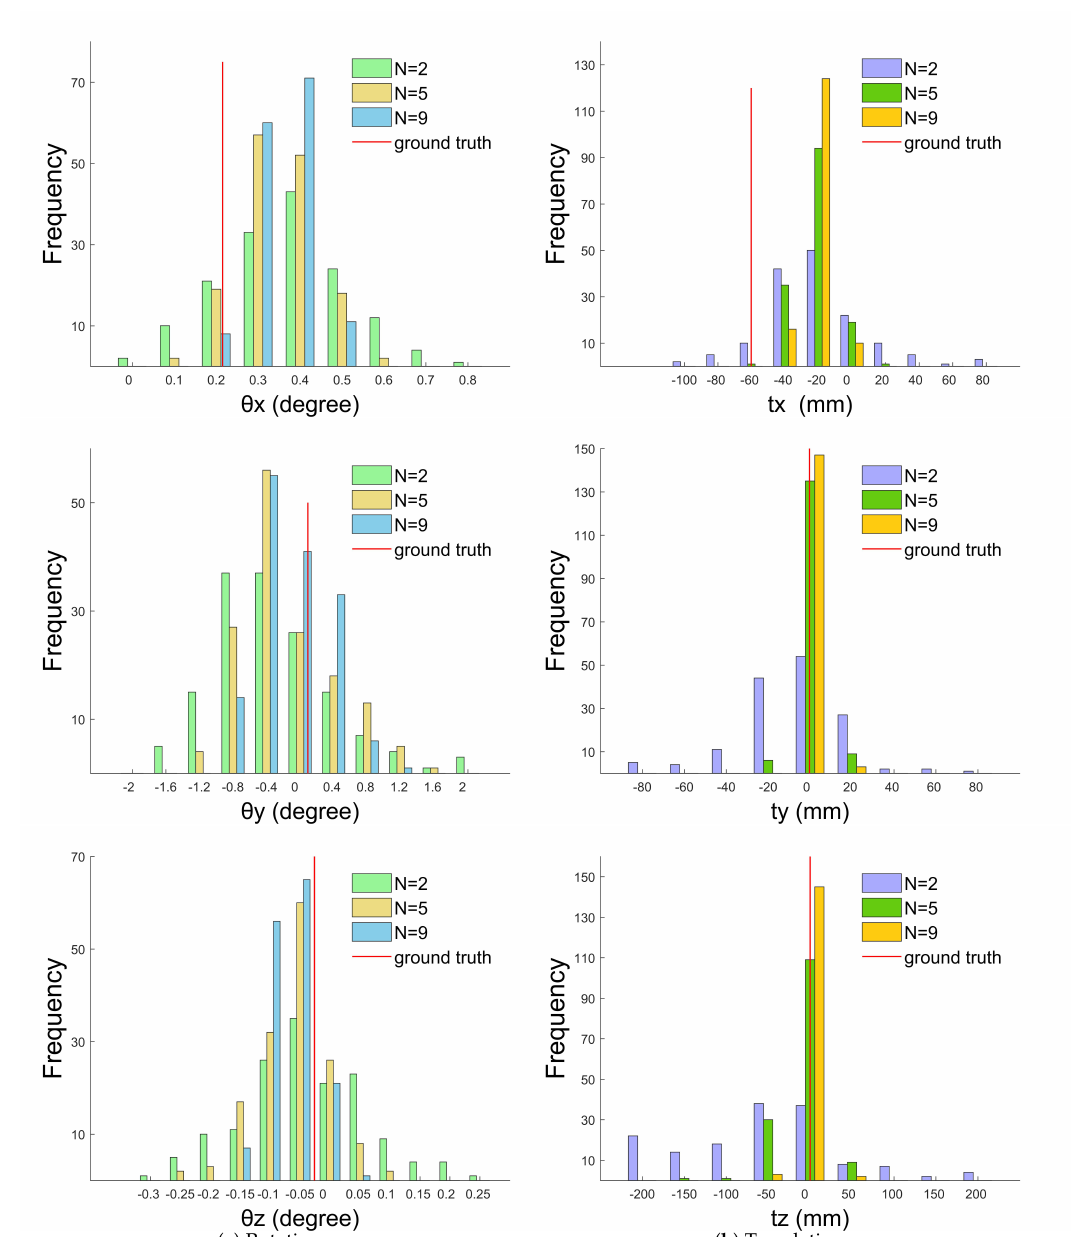
Figure 12. Distribution of initial extrinsic parameter solutions. N represents the number of poses we use to get an initial